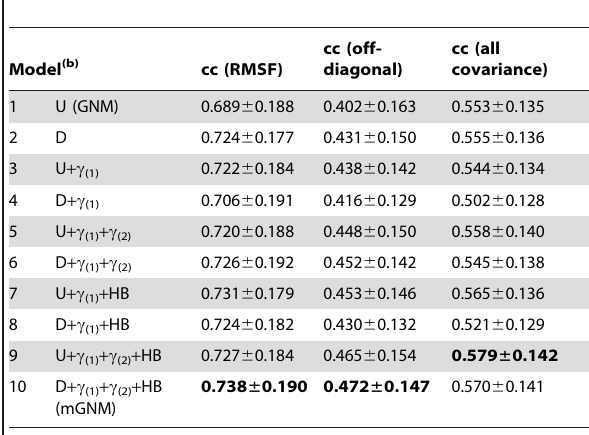
(a) Results obtained for the test set of proteins listed in Table S2. (b) Symbols used are: U – Uniform ( c =1) force constant; D - distance-dependent ( c =1/d 2 ) force constant; c (1) – Nearest neighbor interactions are increased by a factor of 10; c (2) – Second neighbor interactions are changed by a factor of 2 1 in U models or 2 5 in D models; HB – Interactions between residues joined by backbone hydrogen bonds are increased by a factor of 10. Values by protein can be found in Table S3.